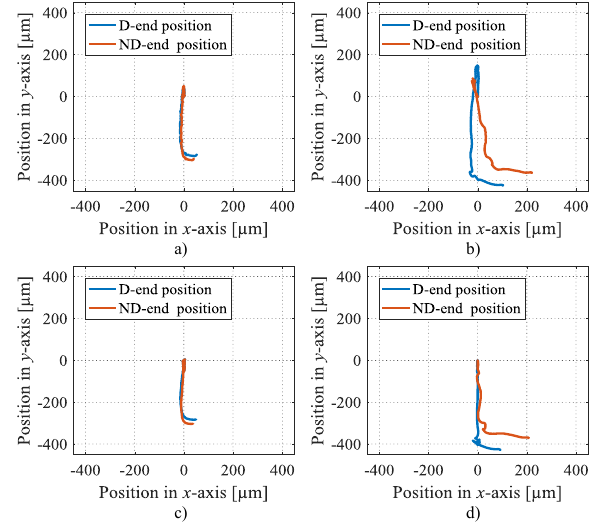
Figure 9: Simulated and measured rotor lift-up from the backup bearings. Initially, the rotor is lying on the backup bearings, and after the controller is enabled, the rotor is magneti- cally levitated to the operating point, that is the origin ( x, y ) = (0 , 0). Simulation and measurement results for the pole placement controller are shown in a) and b), and for the LQR controller in c) and